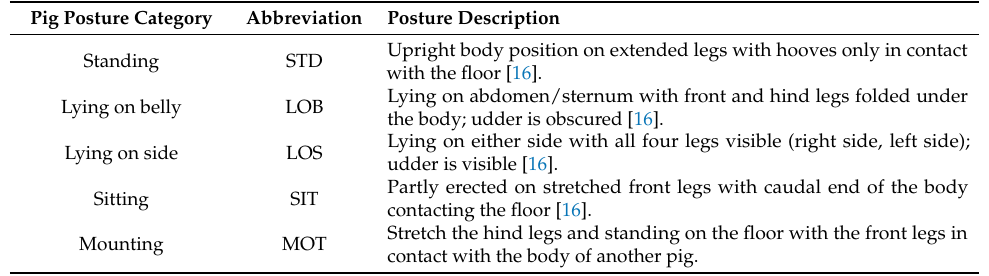
Table 1. Definition of pig postures.